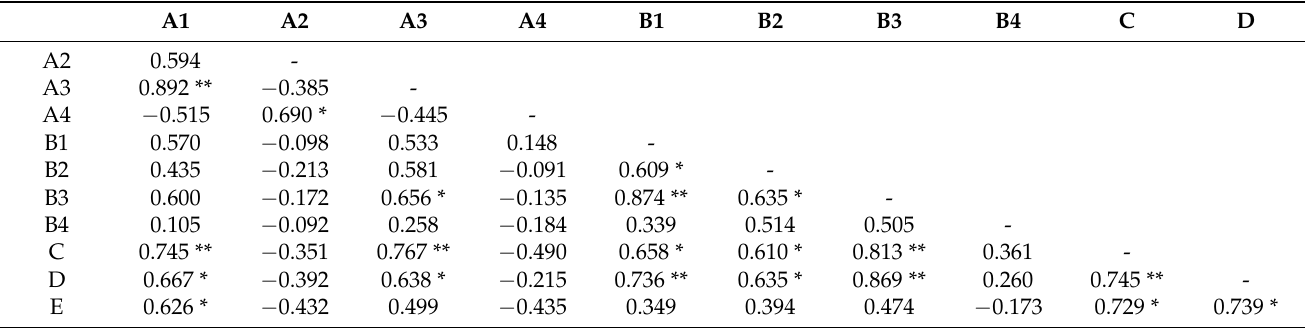
Table 2. Correlation Coefficients between Lower Extremity Muscle Strength and Aerobic Capacity.